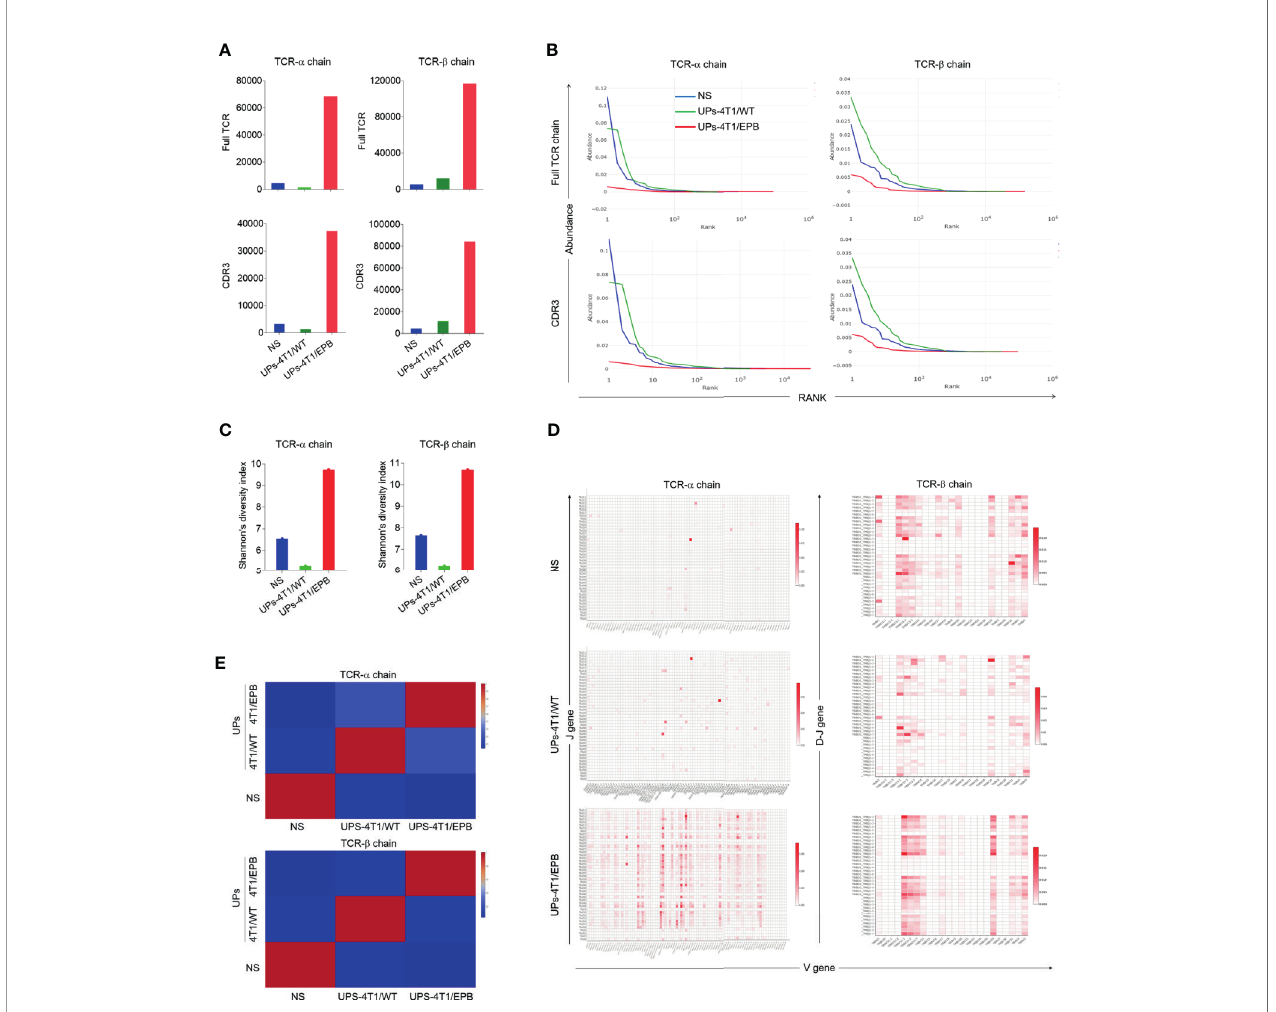
FIGURE 3 | Ubiquitinated proteins (UPs)-4T1/epirubicin (EPB) nanovaccine induced the in fi ltration of CD8 + CTLs with high T cell receptor (TCR) repertoire diversity in 4T1/ WT and 4T1/EPB tumor-bearing mice. The TCRs of CD8 + TILs from Figure 2G were pro fi led with high-throughput TCR sequencing. (A) Number of distinct TCR and CDR 3 clonotypes on TCR ab chain in different groups. (B) The rank abundance curve of TCR and CDR 3 clonotypes on TCR ab chain in different groups. (C) The Shannon diversity index of TCR repertoire on TCR ab chain in different groups. (D) V-J gene usage heat maps for TCR a chain and V-DJ gene usage heat maps for TCR b chain of CD8 + TILs in different groups. (E) Heat map of similarities in CDR 3 aa usage among different TCR ab repertoires analyzed by Pearson correlation. NS, normal